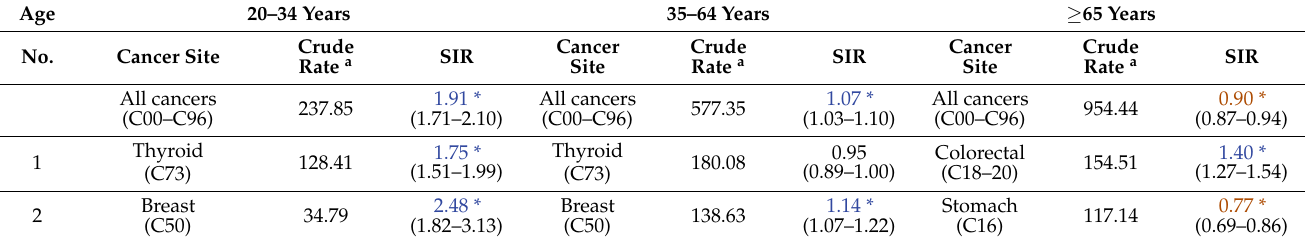
Table 4. Incidence rates of major cancers according to age in female patients who underwent